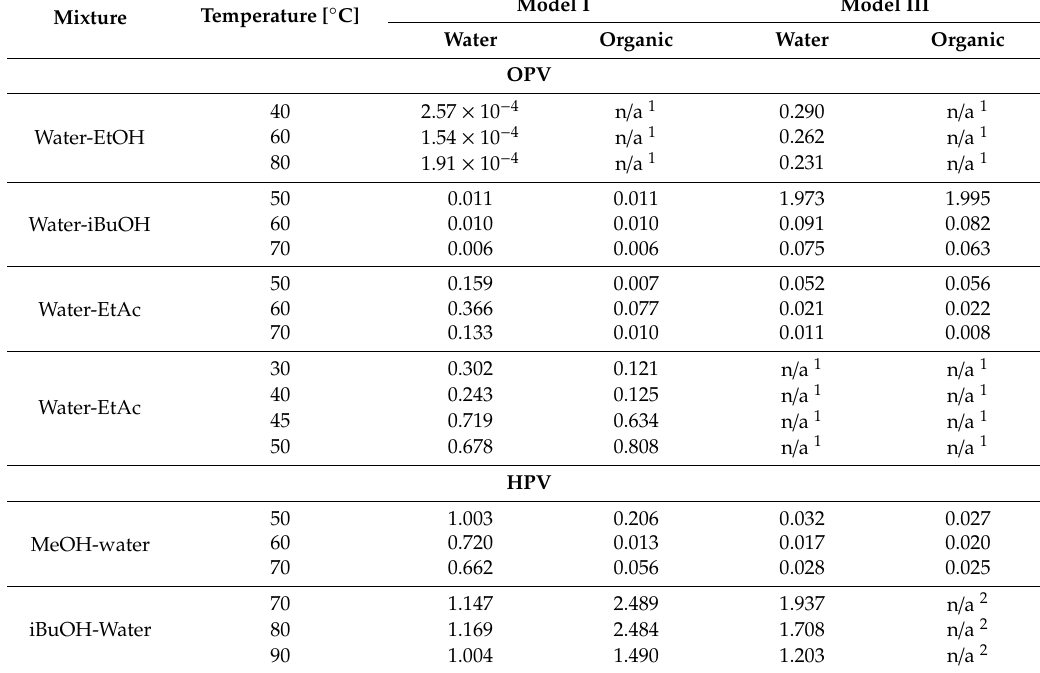
Table 4. Objective functions temperature